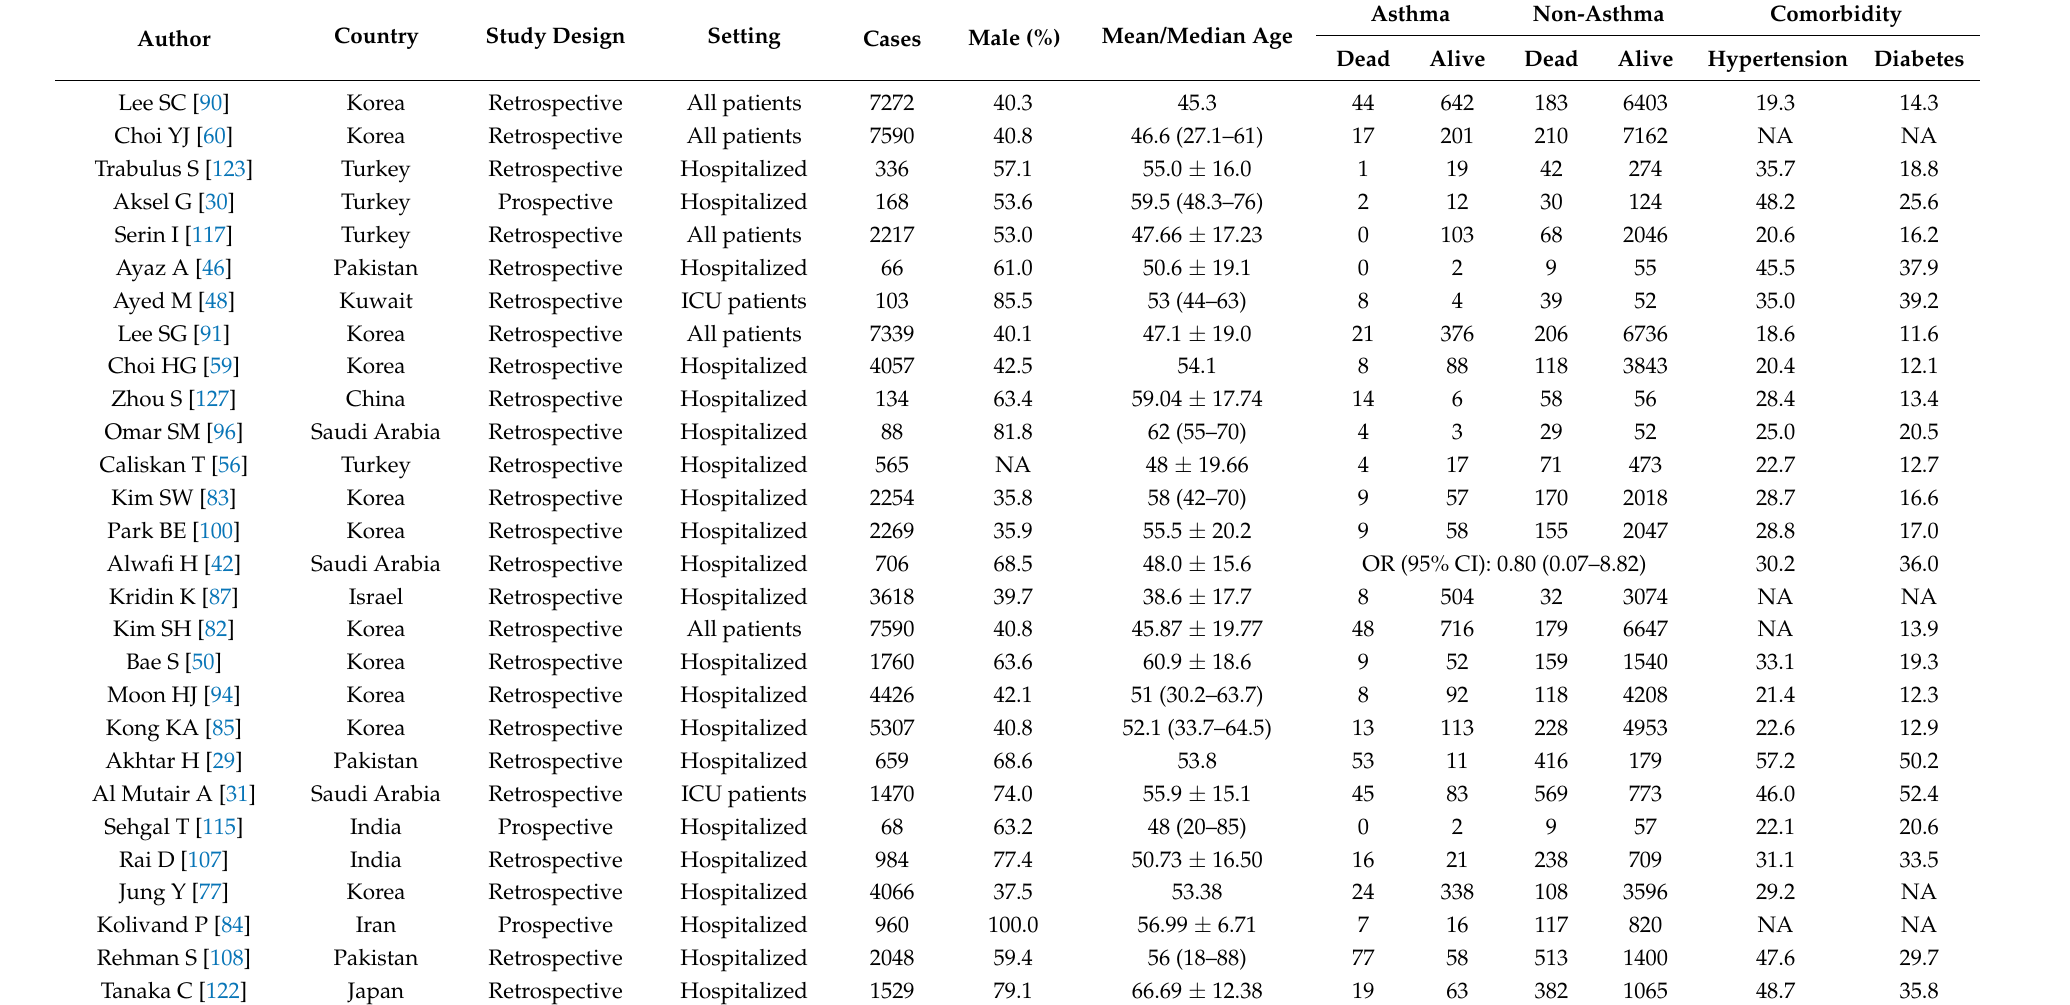
Table 1. Main characteristics of the included